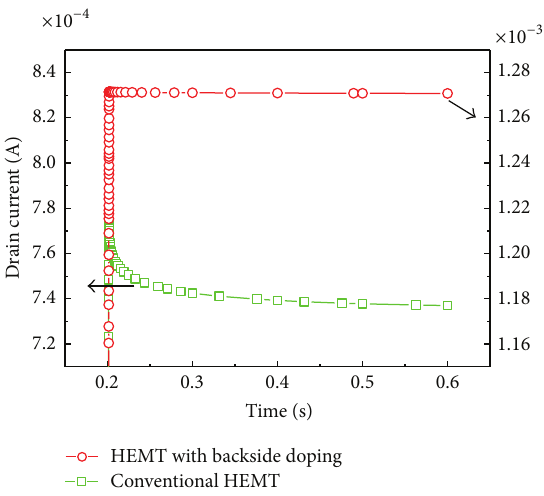
Figure 8: Comparison before and after backside